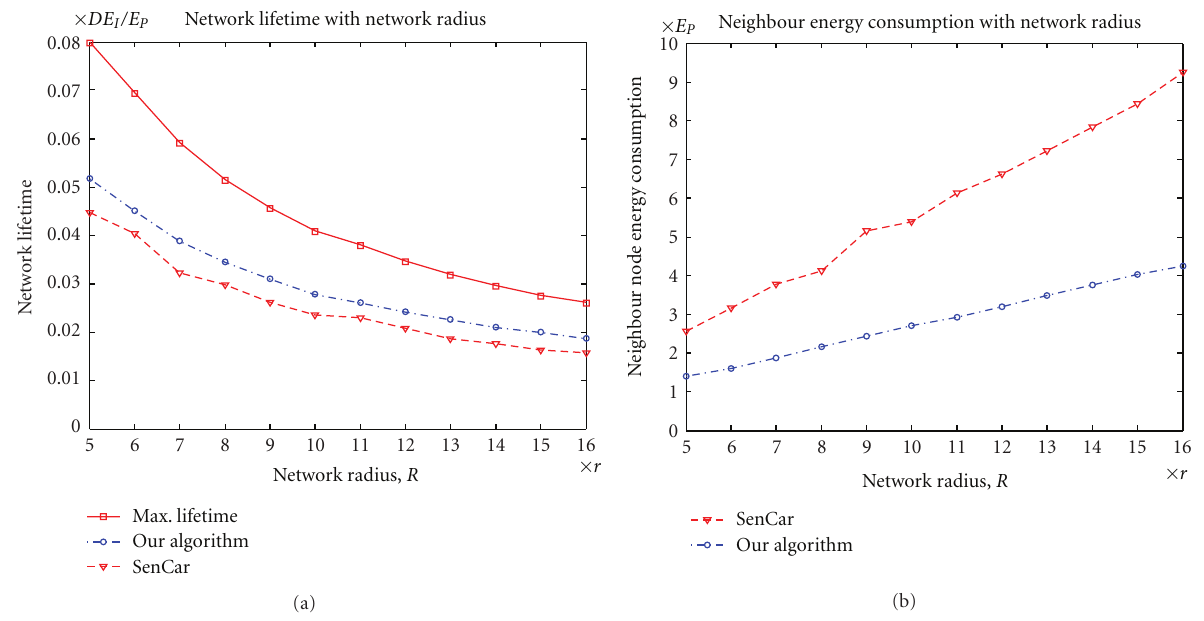
Figure 7: (a) Network lifetime as it varies with network radius, for our algorithm, SenCar algorithm, and the maximum lifetime. (b) The energy consumption for neighbouring sensor nodes of a cluster head for our algorithm and SenCar algorithm as the network radius is